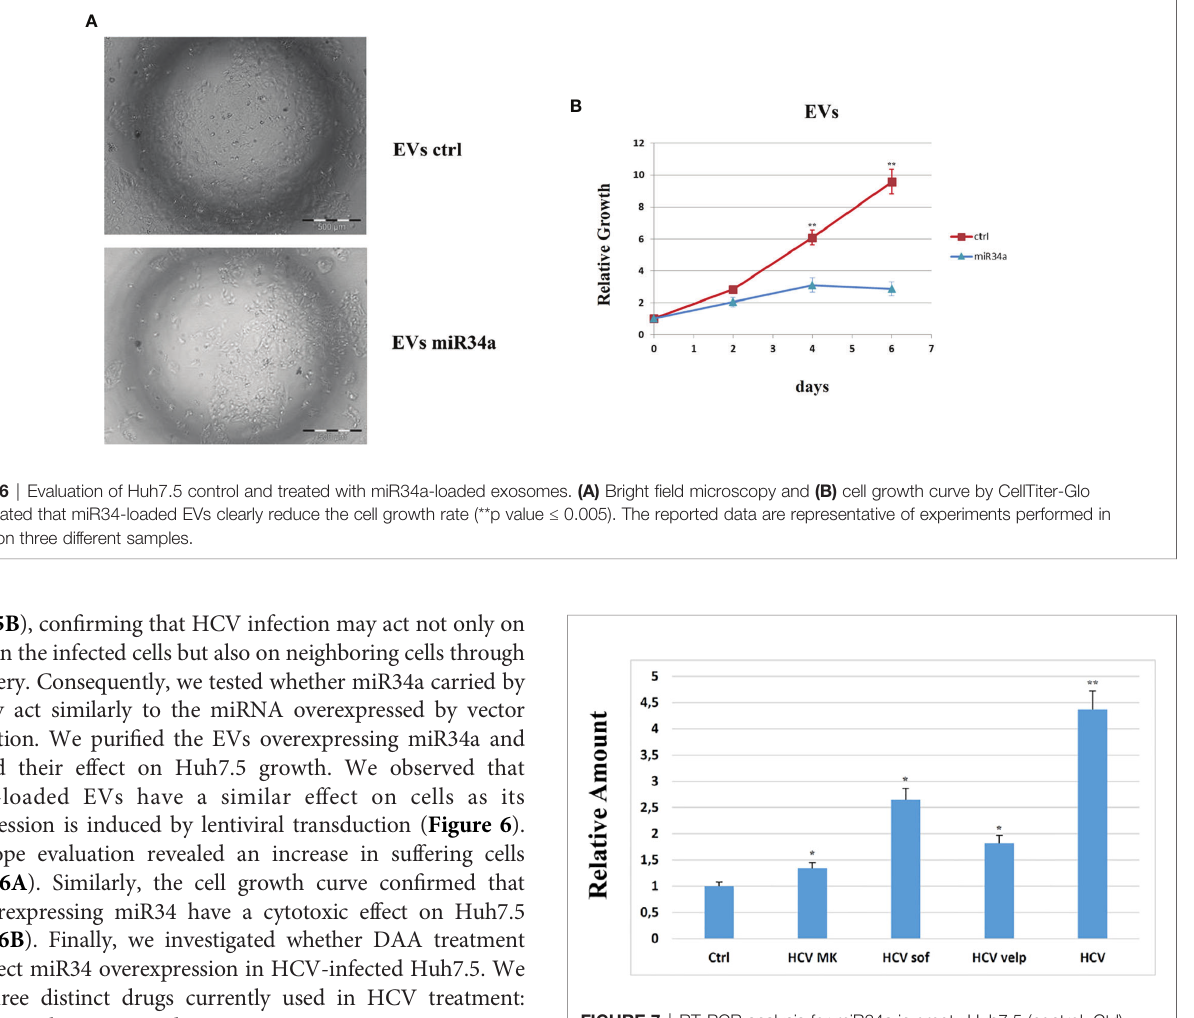
FIGURE 7 | RT-PCR analysis for miR34a in empty Huh7.5 (control, Ctrl), HCV infected, and Huh7.5 treated with sofosbuvir, velpatasvir, and grazoprevir for 3 weeks at a concentration of 10 nM; the absence of virus after treatment was evaluated at 15 days of treatment by immunoassay (data not shown). The reported data are representative of experiments performed in triplicate on three different samples (p value * ≤ 0.05, ** ≤